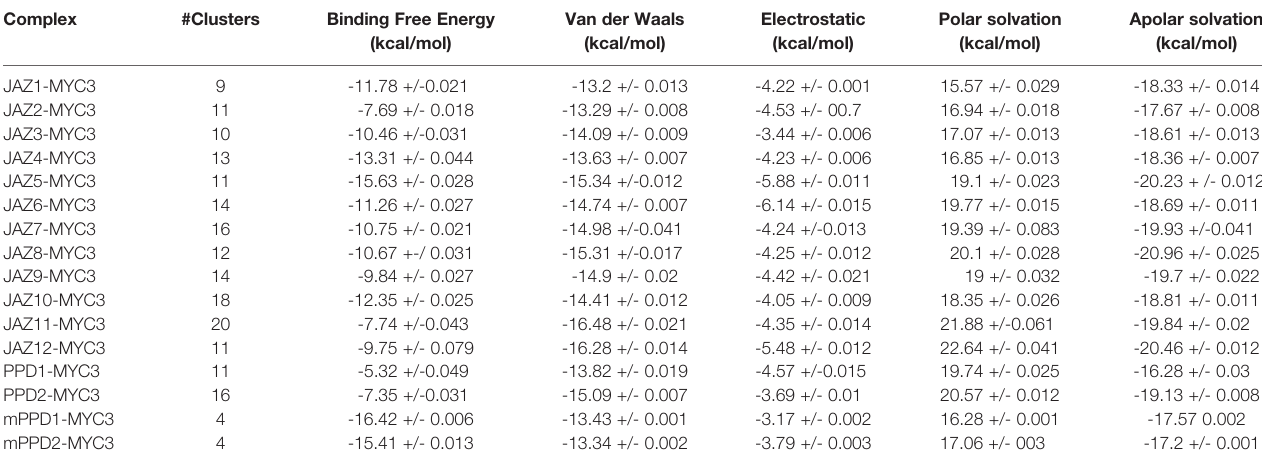
TABLE 3 | Summary of the energy pro fi le of JAZ-MYC3, PPD-MYC3, and mPPD-MYC3 complexes.